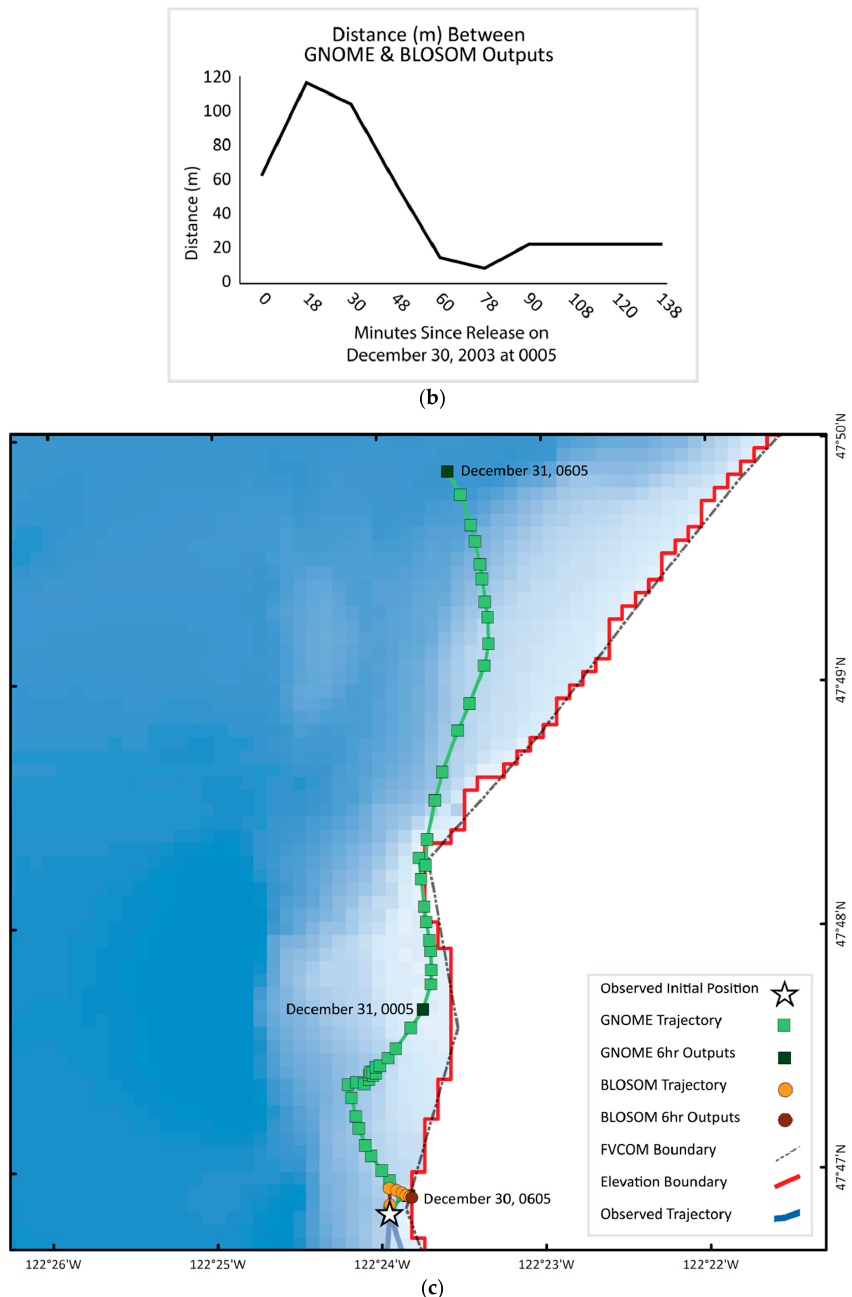
Figure 15. ( a ) Trajectories showing beaching differences, parameters for these simulations can be found in Table 8; test 5. ( b ) Distance between GNOME’s and BLOSOM’s trajectories as a function of time during the first two hours of the simulation for test 5, trajectories are plotted in ( a ). ( c ) GNOME’s trajectory after refloating at 18:53 is shown; test 5.